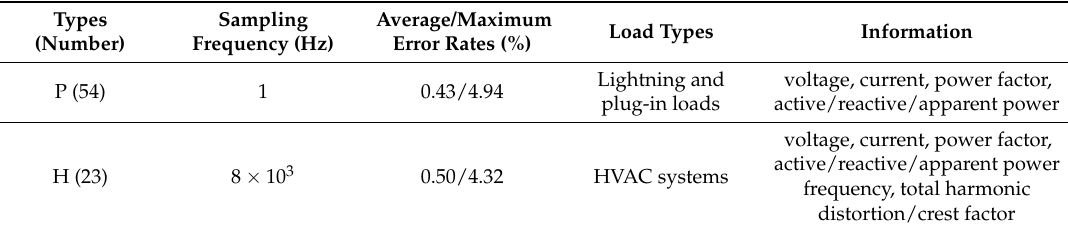
Table 2. Features of P-type and H-type IoT sensors.